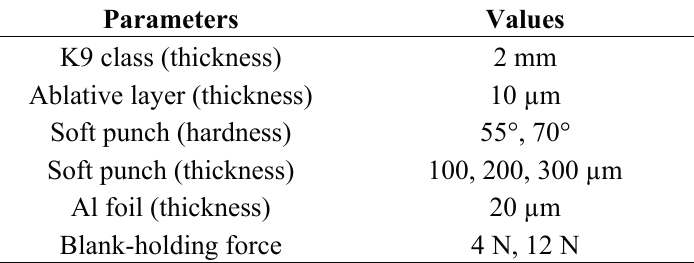
Table 3. The overview of experimental